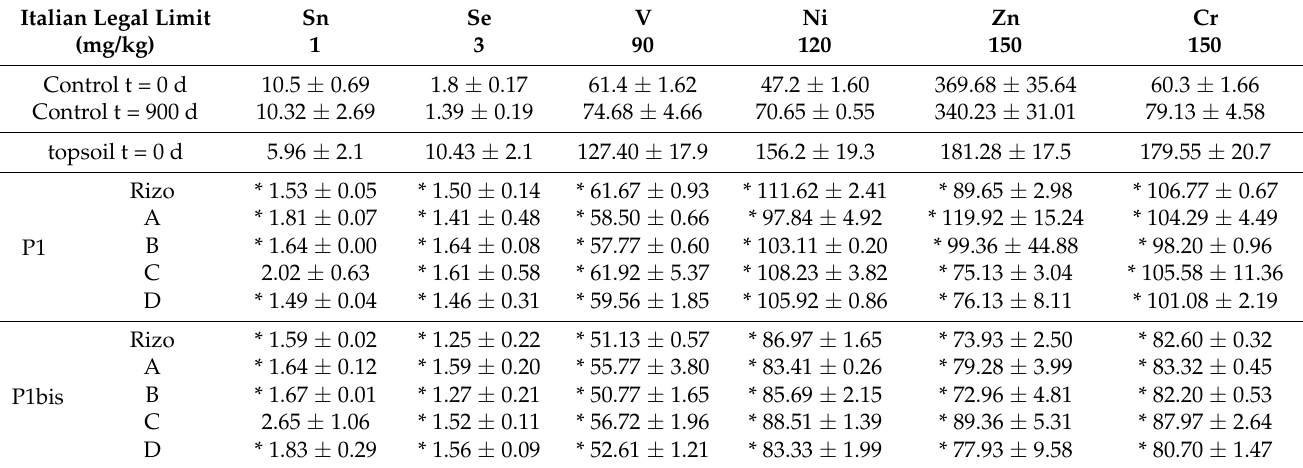
Table 5. Heavy metal concentrations (average values expressed as mg/kg ± standard deviation) detected in: (i) soil samples at 0 day (topsoil: 0–20 cm depth) and 900 days after poplar planting. Rizo: soil surrounding the root system at 0–30 cm depth; A: 0.25 m distance from the trunk and 0–20 cm depth; B: 0.25 m distance from the trunk and 20–40 cm depth; C: 1 m distance from the trunk and 0–20 cm depth; D: 1 m distance from the trunk and 20–40 cm depth) and (ii) soil samples at day 0 and day 900 taken from the control plot zone. Statistical differences ( p < 0.05) are reported with a star